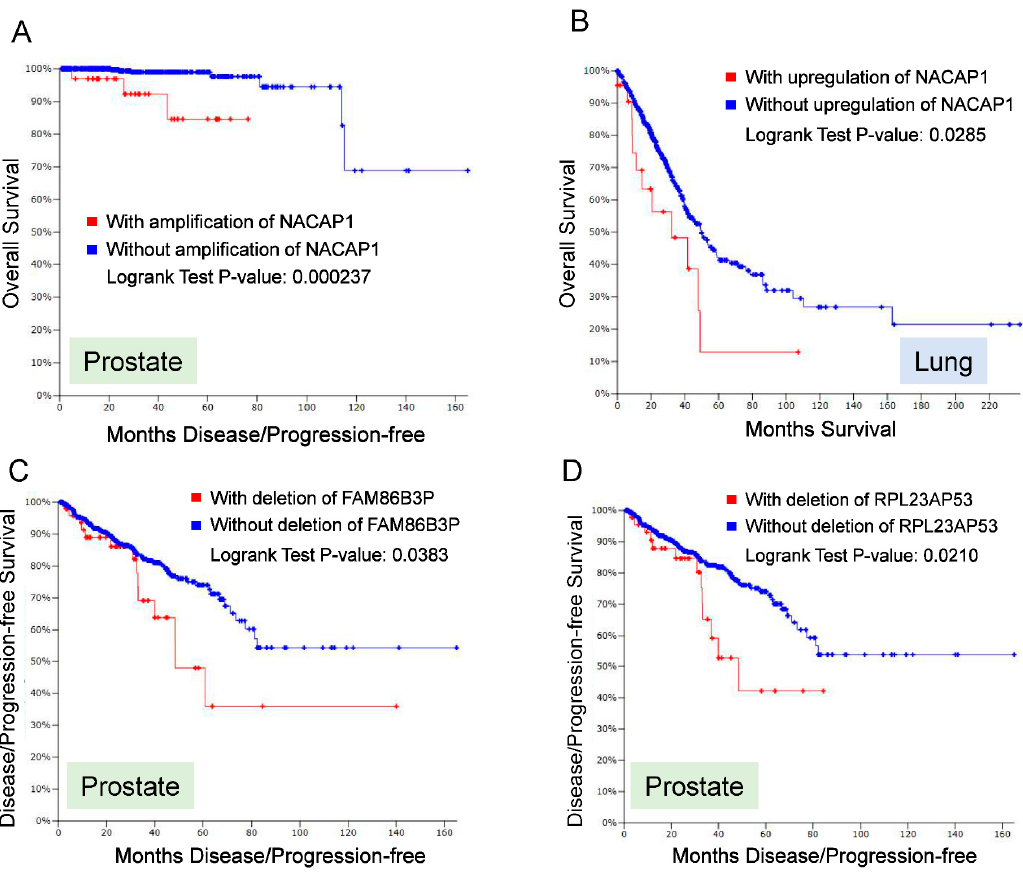
Figure 3. Alterations of pseudogenes are associated with overall survival or disease free survival.